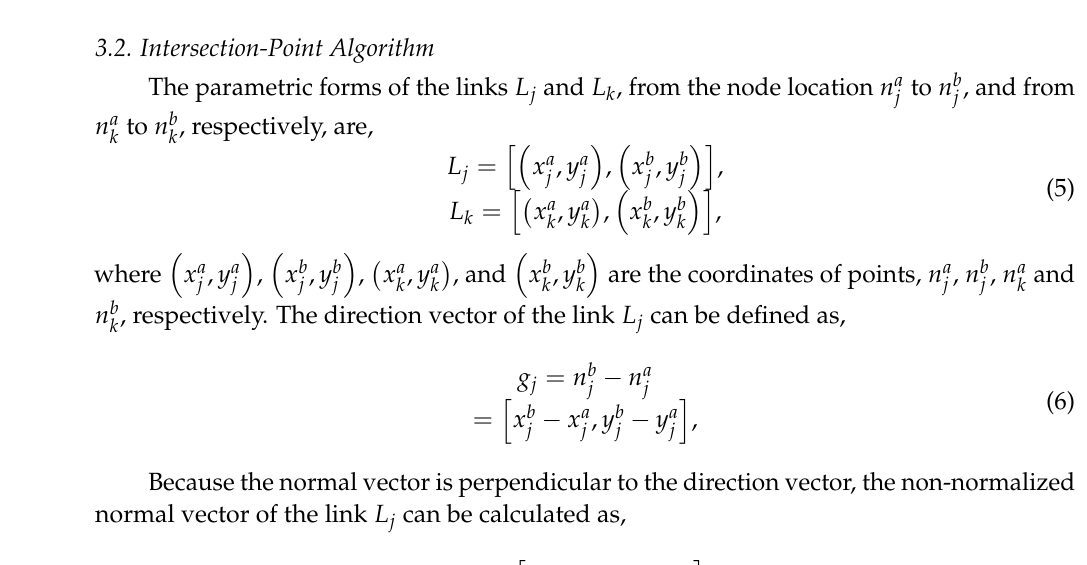
Figure 3. Plots of variances of the RSS data of all the wireless links in the network when the length of the sliding window 𝑐 equals 15.